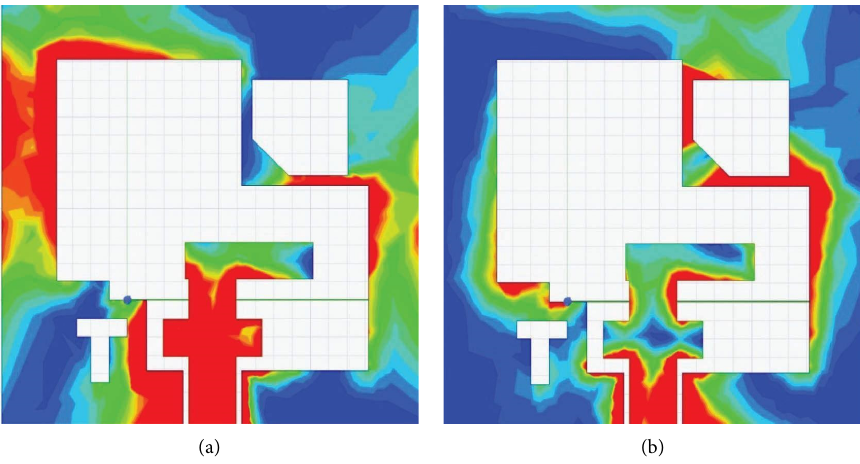
Figure 4: Current distribution at (a) 4.75 GHz and (b) 7.05GHz.